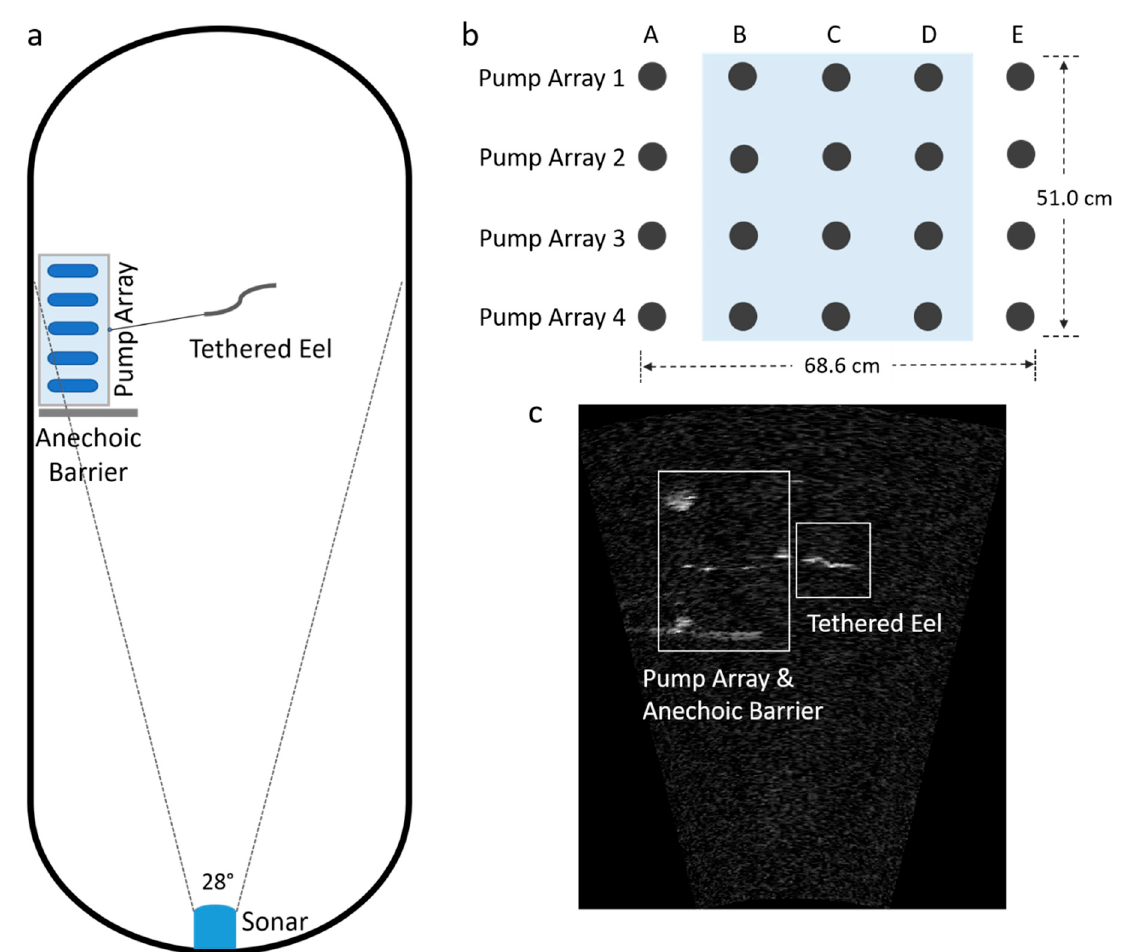
Figure 1. The setup of the laboratory experiments. ( a ) Test tank component diagram including the oval-shaped tank (7.3 m long, 3.0 m wide, and 2.5 m deep), the pump array, the anechoic barrier, sonar, and the tethered eel. ( b ) Diagram of pump arrangement used to generate flow field in the test tank. Shaded region indicates the region where velocity measurements were made and region where eels were confined to be imaged. ( c ) An example of the sonar image snapshot showing a tethered eel at a 5-6 m detection range and the pump array and anechoic barrier in the background.